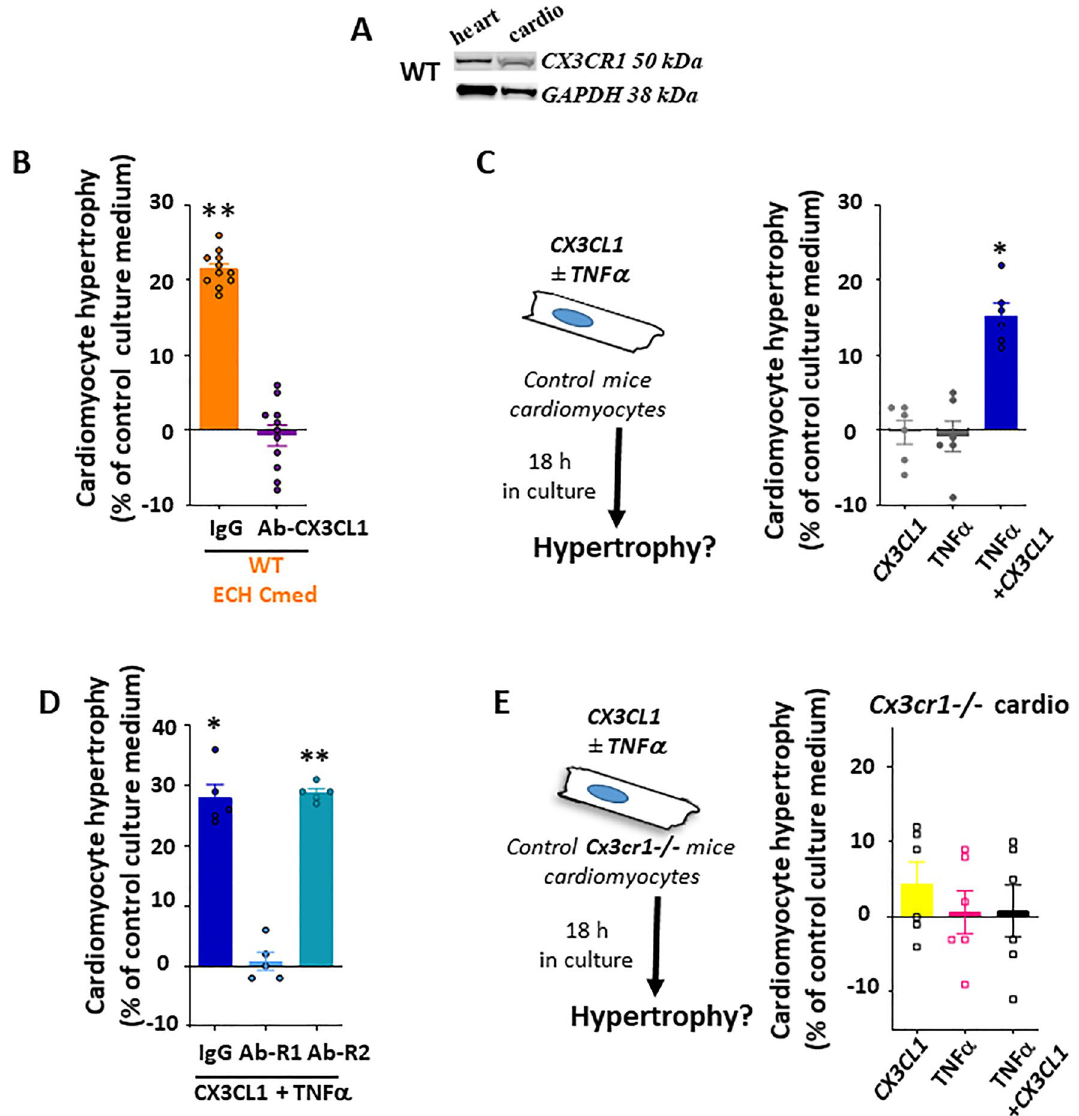
Figure 4. Determinant role of the CX3Cl1/CX3CR1 axis in the pro-hypertrophic effect of ECH Mφ-enriched CD45 + cells in adult WT cardiomyocytes: synergism between CX3CL1 and TNFα. ( A ) CX3CR1 protein expression in WT heart tissue (15 µg) or isolated adult WT cardiomyocytes (50 µg). Full unedited gels are provided in the supplementary material as well as detailed procedure (Figure S10). ( B ) Cmed from adherent CD45 + cells isolated from ECH WT mice enhances hypertrophy of WT cardiomyocytes in a CX3CL1- dependent manner. Experimental procedure described in Fig. 2A. ( C ) CX3CL1 requires the synergistic action of TNFα to enhance hypertrophy in control WT cardiomyocytes. ( D ) The pro-hypertrophic impact of CX3CL1 + TNFα relies on TNFR1 binding of TNFα. ( E ) Either alone or in combination, CX3CL1 and TNFα are without hypertrophic effect on adult cardiomyocytes from control Cx3cr1 -/- mice. Mean ± SEM of 2–6 experiments performed in triplicate. Cardiomyocytes from 2–6 mice (225–750 cell area quantified per condition per experiment), Cmed from 4–10 mice, Kruskal–Wallis followed by Dunn post-hoc test; * p < 0.05, ** p < 0.01 vs Ct